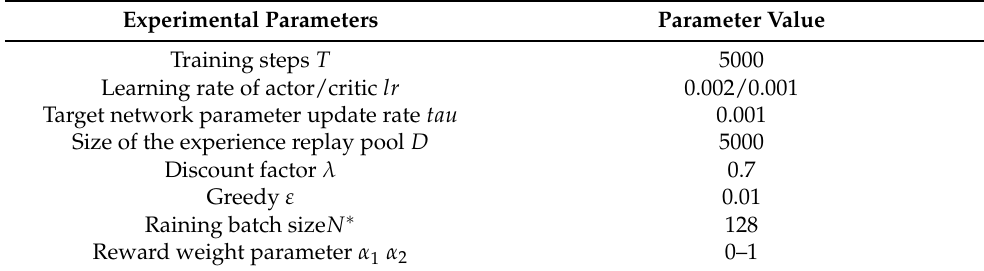
Table 4. The specific configuration of